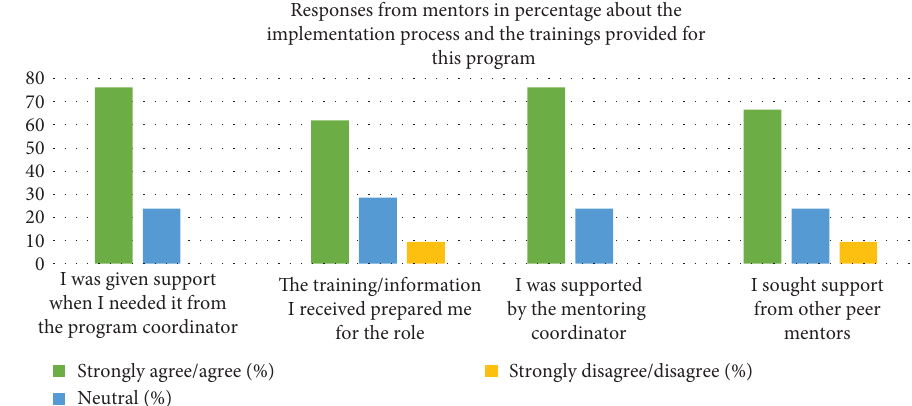
F IGURE 1: Bar chart showing the percentages of responses from mentors only, about the implementation process and the trainings provided for this